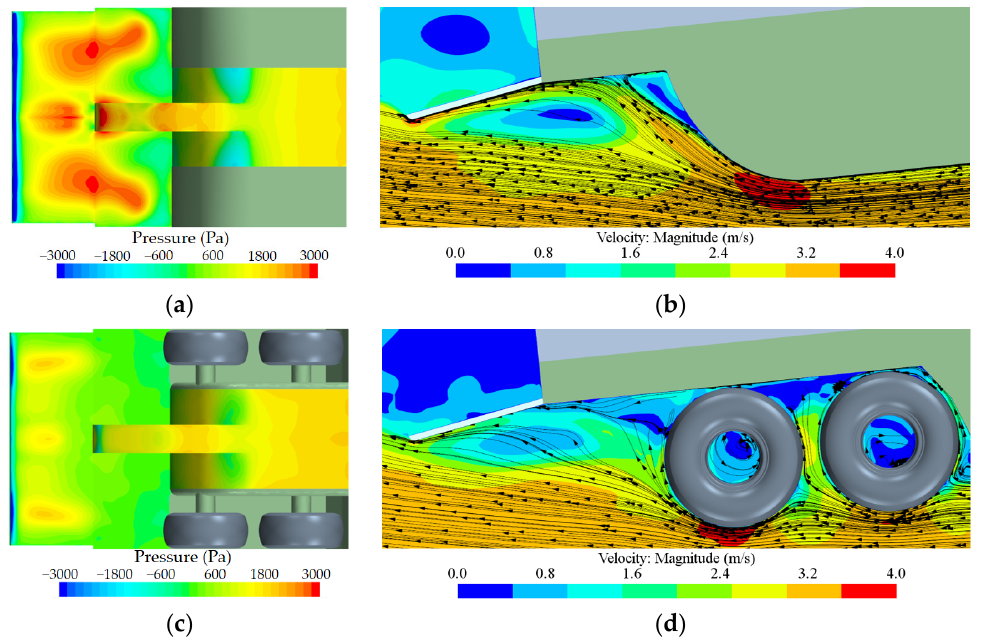
Figure 16. Pressure, velocity and streamline distribution at the stern of the NW model and TS model at Fr = 0.624. ( a ) Pressure distribution in the stern of the NW model; ( b ) Velocity and streamline distribution in the stern of the NW model; ( c ) Pressure distribution in the stern of the TS model; ( d ) Velocity and streamline distribution in the stern of the TS model.